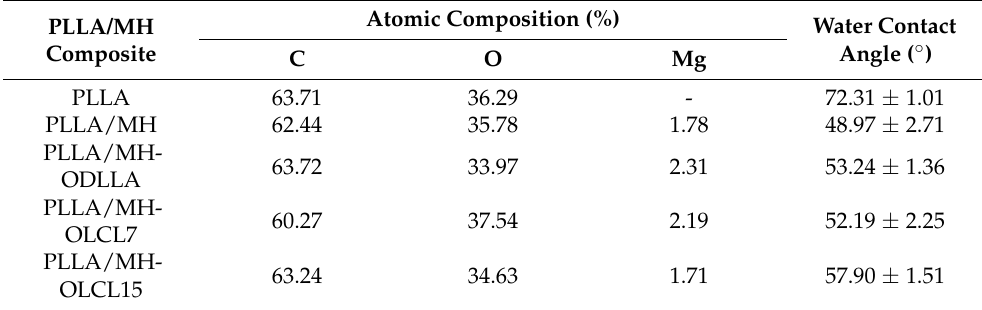
Figure 3. The PLLA/MH composite characterization. Representative ( A ) SEM and ( B ) EDS Mg map- ping of the PLLA, PLLA/MH, PLLA/MH-ODLLA, PLLA/MH-OLCL7, and PLLA/MH-OLCL15. Scale bar: 10 µ m. ( C ) ATR-FTIR spectra and ( D ) TGA thermograms of each PLLA/MH composite. Table 2. SEM-EDS analysis and water contact angle on the surface of the PLLA/MH